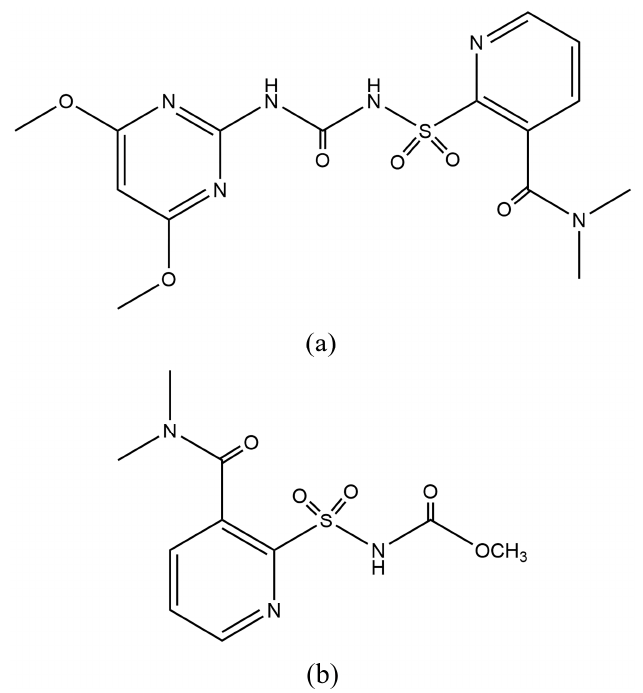
Figure 1. Chemical structure of ( a ) nicosulfuron (NS) and ( b ) [[3-[(Dimethylamino)carbonyl]-2-